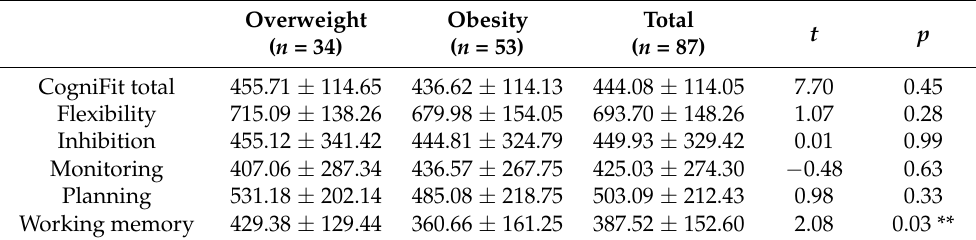
Table 3. Differences in executive function between overweight and obesity ( n = 87).